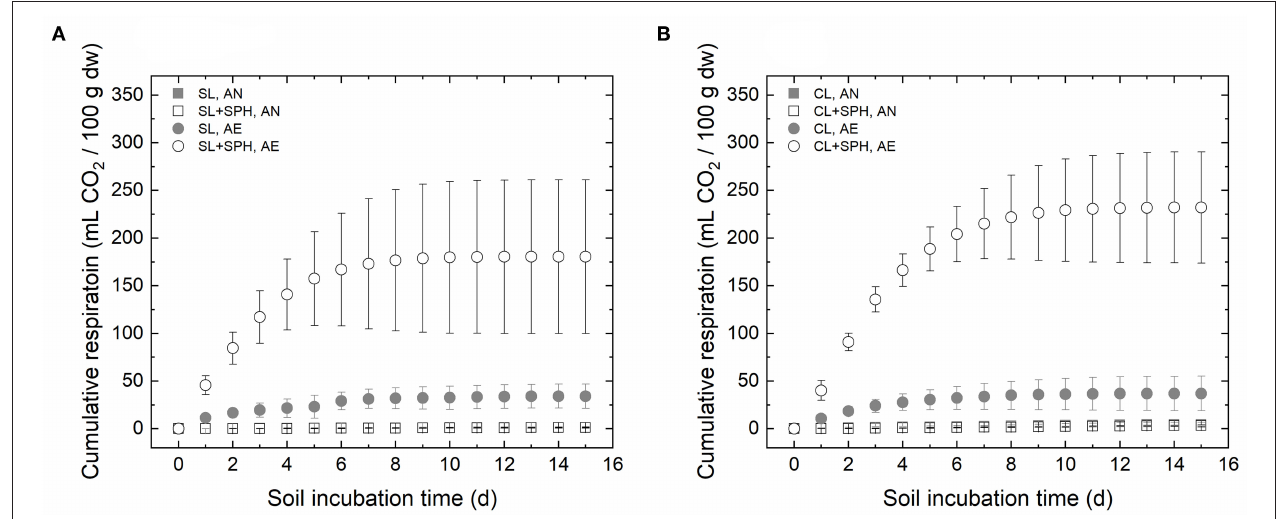
FIGURE 1 | CO 2 accumulation during 15 days in (A) sandy loam (SL) and (B) sandy clay loam (CL), with (2% dw) and without spent pollinator hulls (SPH) under anaerobic and aerobic conditions. AN, anaerobic; AE, aerobic. Bars represent standard deviations ( n =